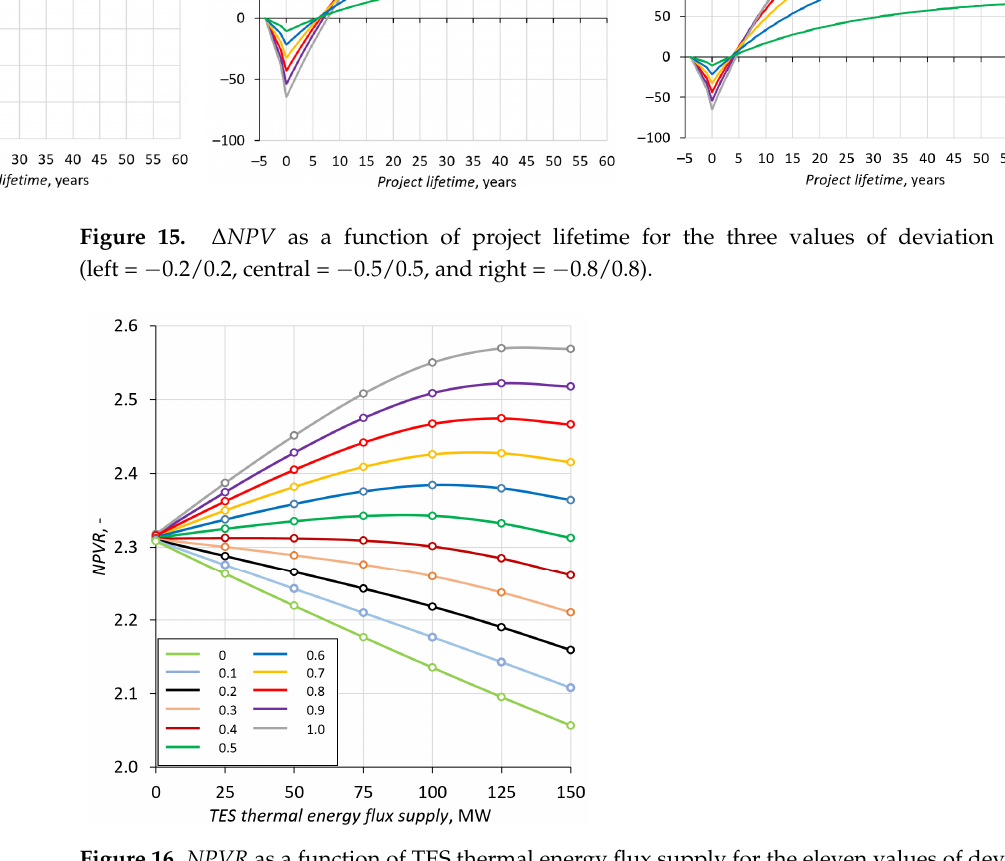
Figure 16. NPVR as a function of TES thermal energy flux supply for the eleven values of deviation index (from 0 to 1, with step 0.1).